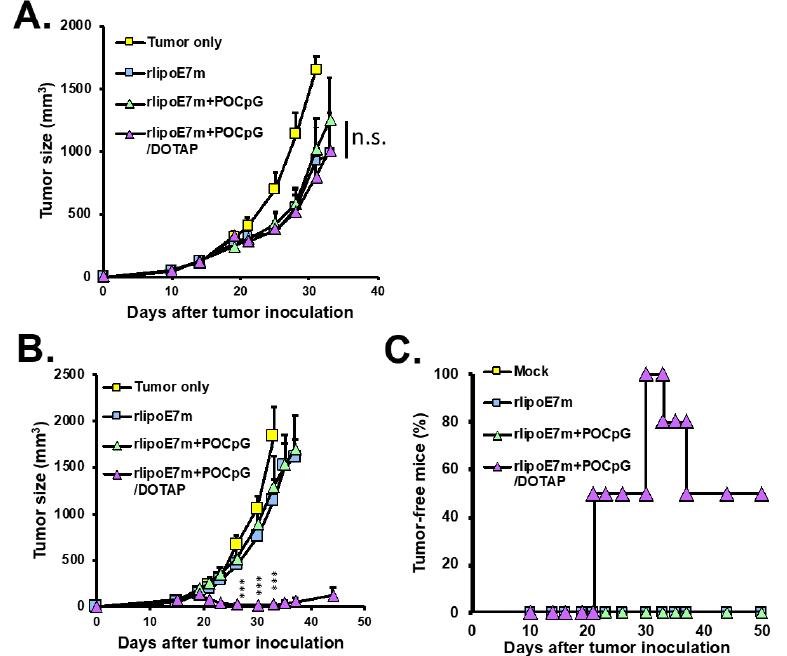
Figure 4. The therapeutic effect of rlipoE7m and POCpG/DOTAP combined via intravenous injection. C57BL/6 mice were inoculated with 2 × 10 5 TC-1 cells. Fourteen days later, TC-1 tumors were larger than 50 mm 3, and the tumor-bearing mice were immunized with rlipoE7m, rlipoE7m + POCpG, or rlipoE7m + POCpG/DOTAP combined via tail vein injection. Mice were immunized once ( A ) or twice ( B ) via the tail vein. ( C ) The percentage of tumor-free mice was calculated by the formula (number of tumor-shrinking mice/number of mice per group) × 100%. Tumor size was monitored three times a week. (The rlipoE7m + POCpG/DOTAP group vs. rlipoE7m + POCpG group, *** p < 0.001. Each mouse group n = 6).